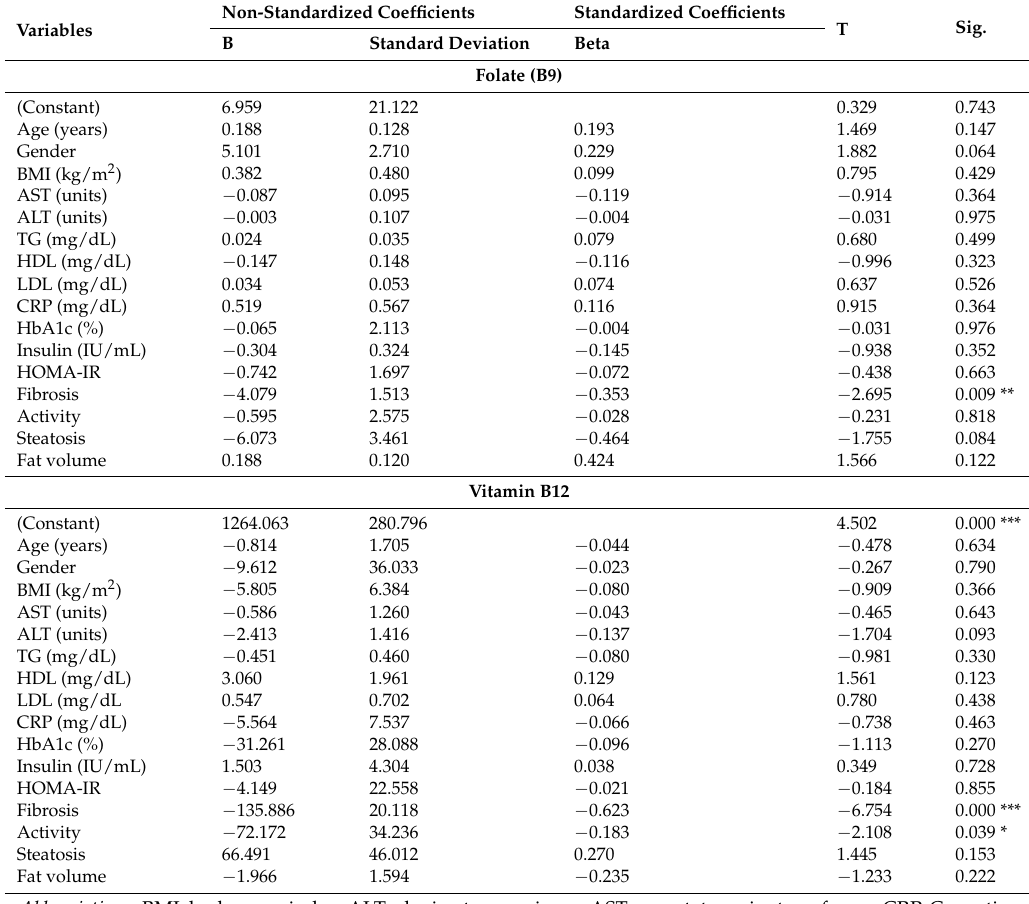
Table 3. Multivariate regressions for each